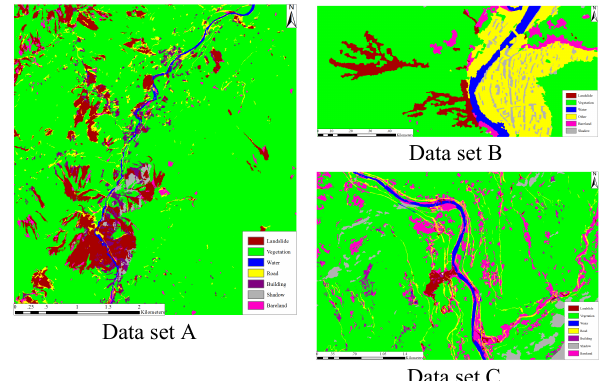
Figure 2. Classification results based on object-oriented